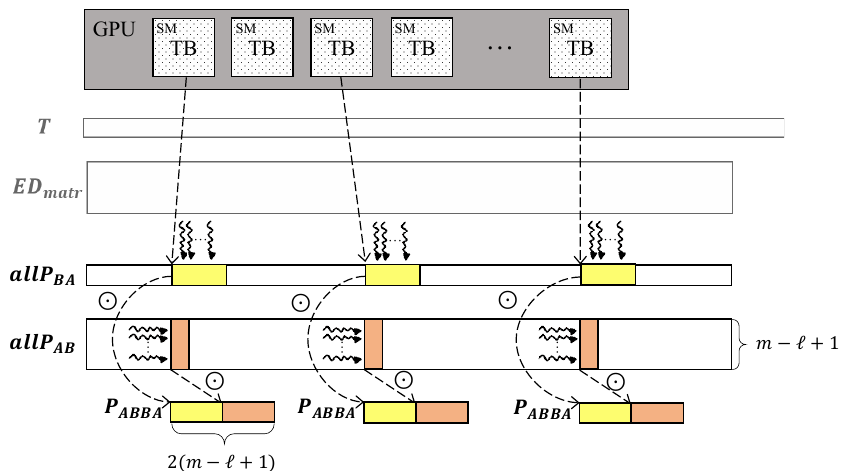
Figure 4. CUDA kernel to compute P ABBA .